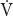
Predicted percent improvements in running velocity depend on the baseline running velocity. (A) Predicted percent improvements in running velocity vs. running velocity, based on a 4% improvement in RE, using several equations from the recent scientific literature. The solid green is based on a quadratic fit through Batliner et al. (2018) data with Pugh’s cubic air resistance term. The green dashed line is based on a linear fit through Batliner et al. (2018) data combined with Pugh’s cubic air resistance term. The difference between the two green lines highlights the importance of the inherent curvilinearity of the O2-velocity relation which substantially alters the magnitude of percent improvement in velocity. (B) Predicted percent improvements in running velocity vs. running velocity, based on 1 to 4% improvements in RE, using Eq. [2], which combines the quadratic equation from Batliner et al. (2018) with Pugh’s cubic air resistance term. Beyond the velocity range of Batliner et al. (2018) (>5.14 m/s) prediction lines are dashed.